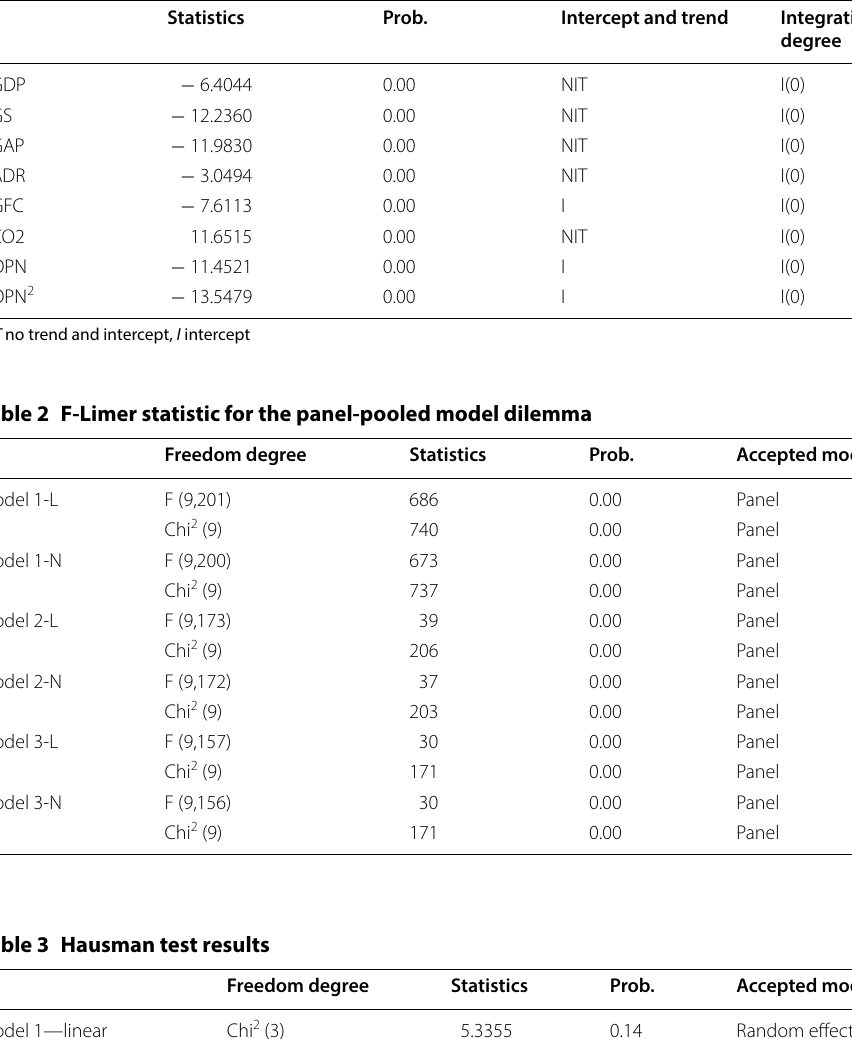
Table 1 Unit root test results